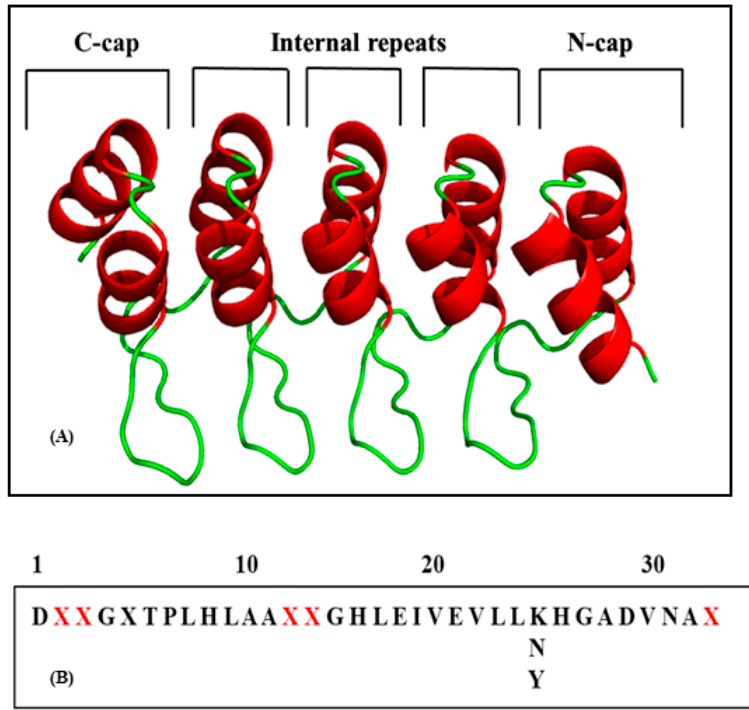
Figure 1. ( A ) Architecture of DARPins (N3C) showing C -cap, N -cap, and internal repeats. ( B ) Con- sensus design of a DARPin repeat containing 33 amino acids showing framework (black) and randomized residues (red).